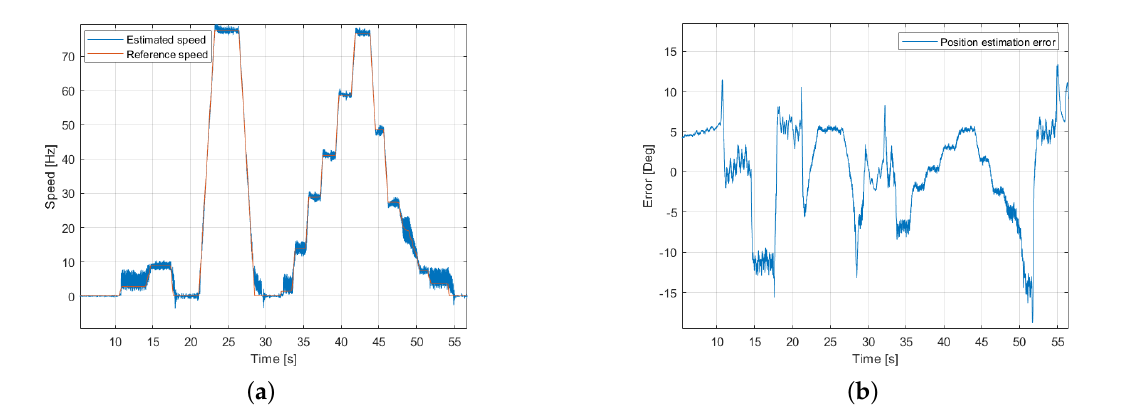
Figure 14. Sensorless drive in a wide speed range with no load. ( a ) Speed tracking. ( b ) Position estimation